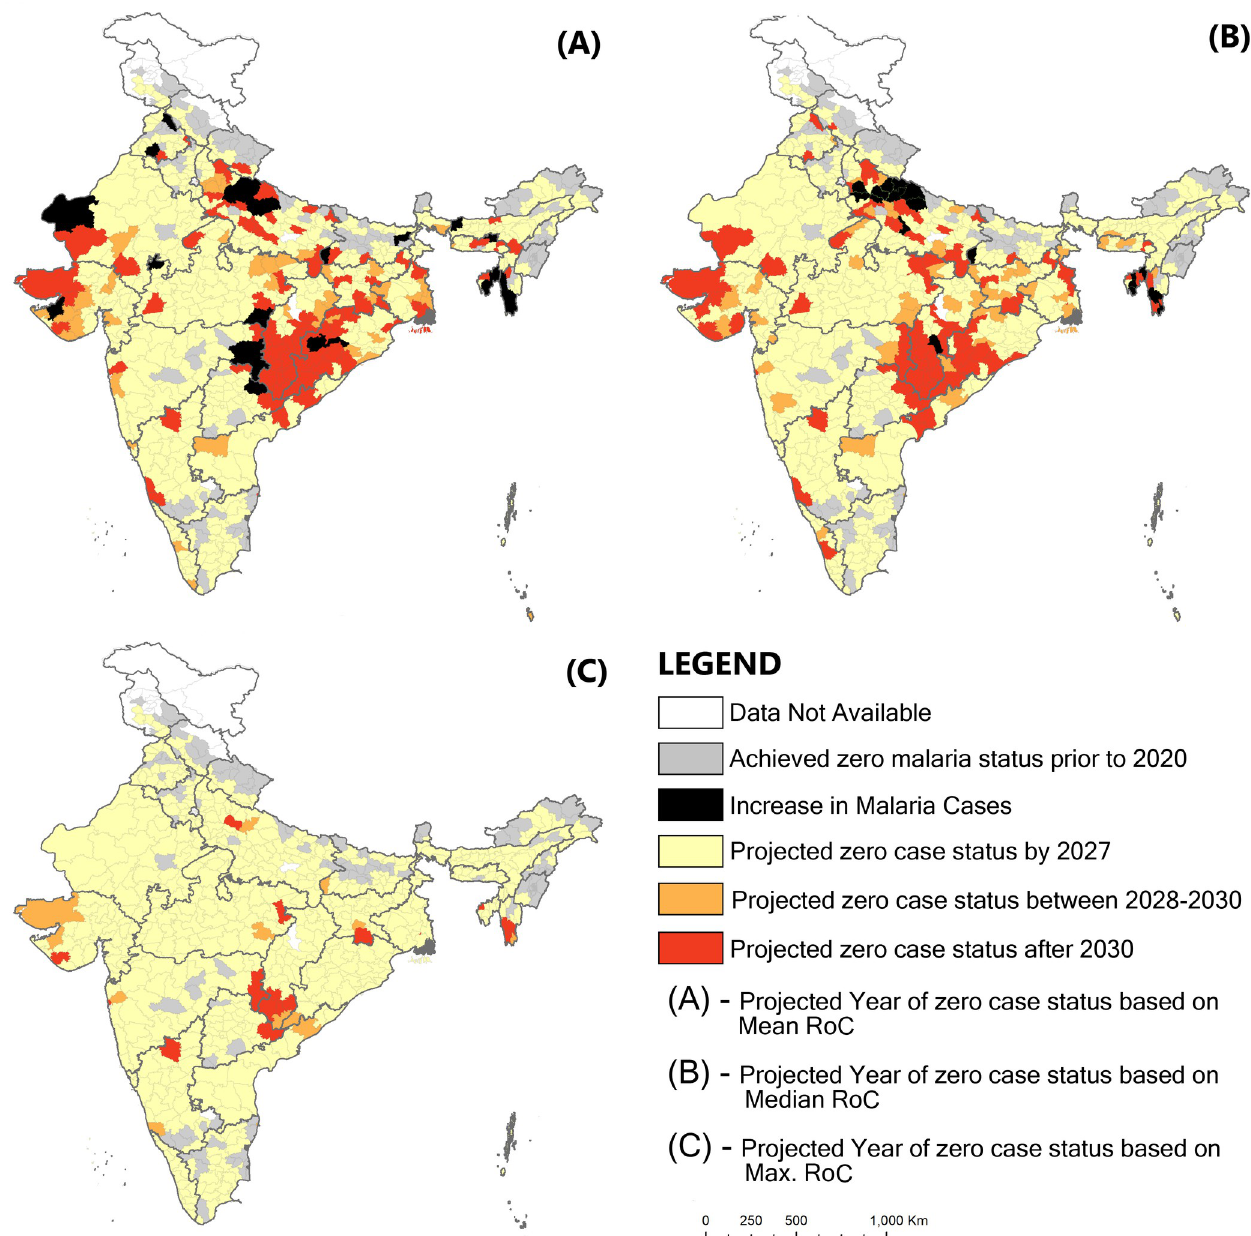
Fig 2. Classification of Indian districts as per projected year of achieving zero case status using three approaches: (A) mean AROC, (B) median AROC and (C) maximum AROC.